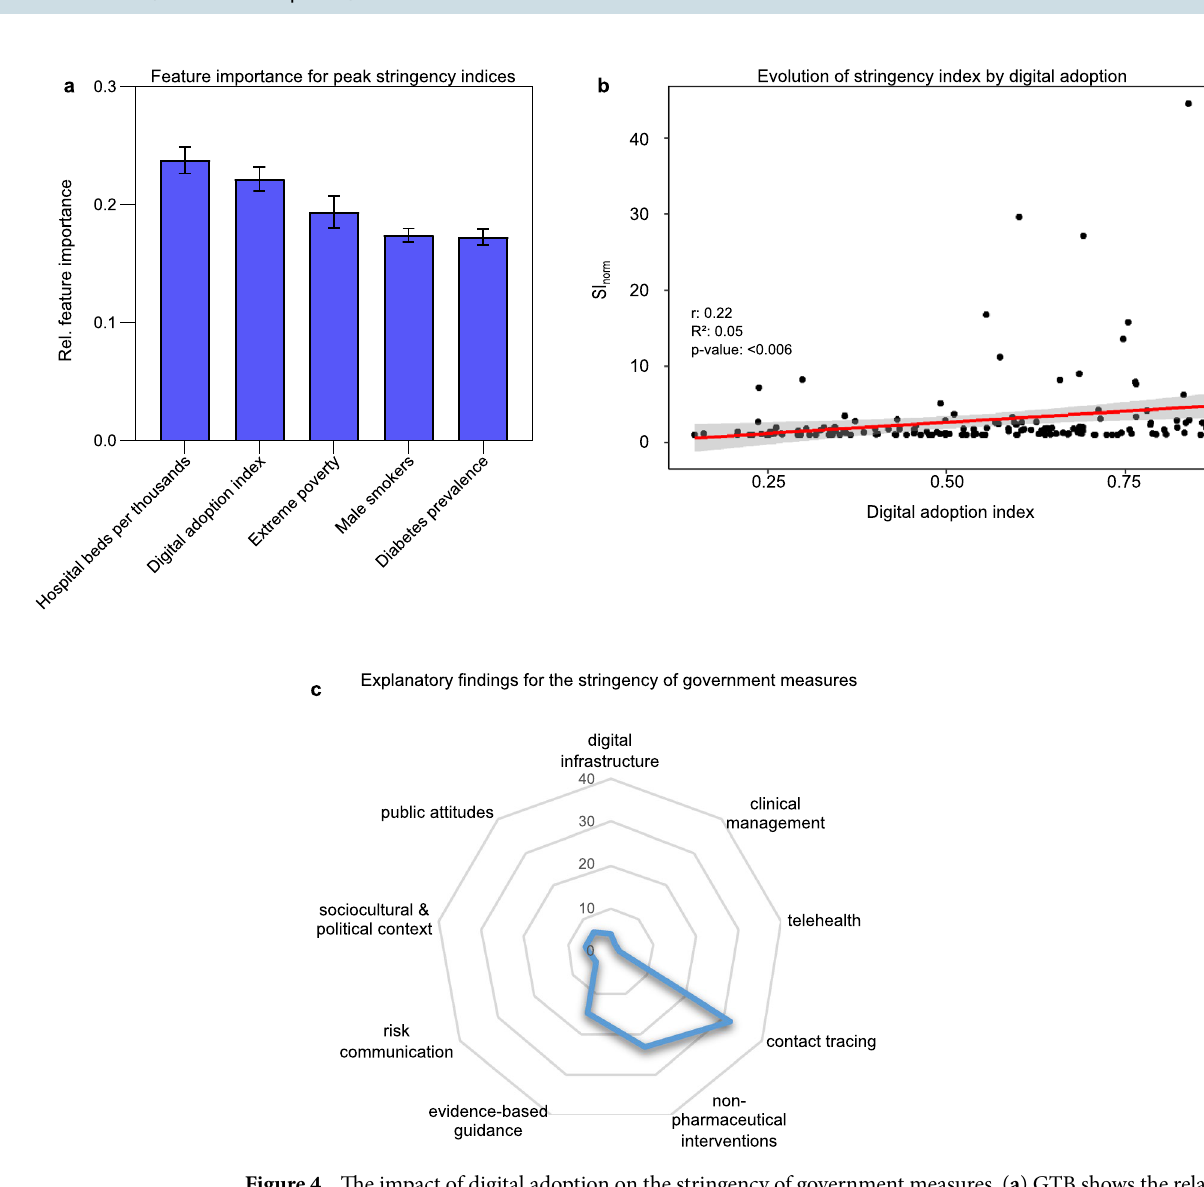
Figure 4. The impact of digital adoption on the stringency of government measures. ( a ) GTB shows the relative importance of characteristics on government stringency indices. Relative feature importance was normalized, and the sum was set to 1.0. Data are expressed as mean ± standard error of the mean. ( b ) The regression model shows that, on average, countries with a higher DAI adopted slightly more stringent policy measures during the first year of the pandemic. To allow for a suitable comparison of the stringency index across countries, we adjusted for the different onsets of the SI (SI norm = SI mean /SI initial ). The area of the 95% confidence interval is shaded gray. ( c ) Findings related to government responses within the scoping review: contact tracing, non- pharmaceutical interventions, and evidence-based guidance. The scale for the radial axis diagrams shows how frequently the keywords occurred in the included